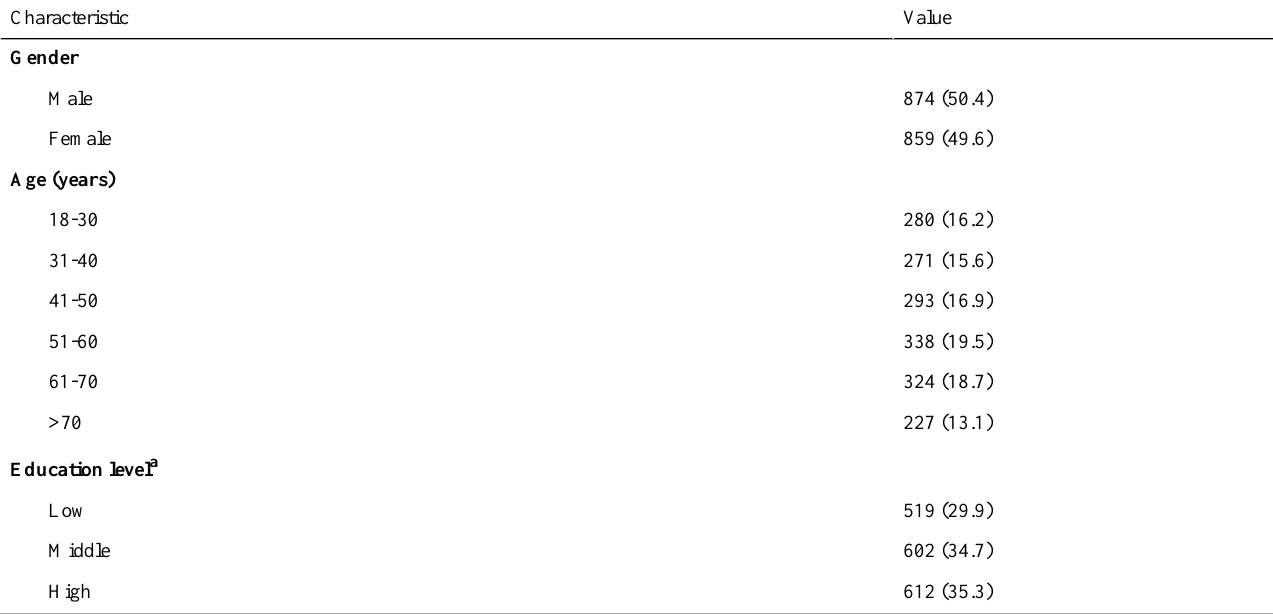
Table 1. Demographic profile of the Dutch internet user sample (N=1733), n (%).